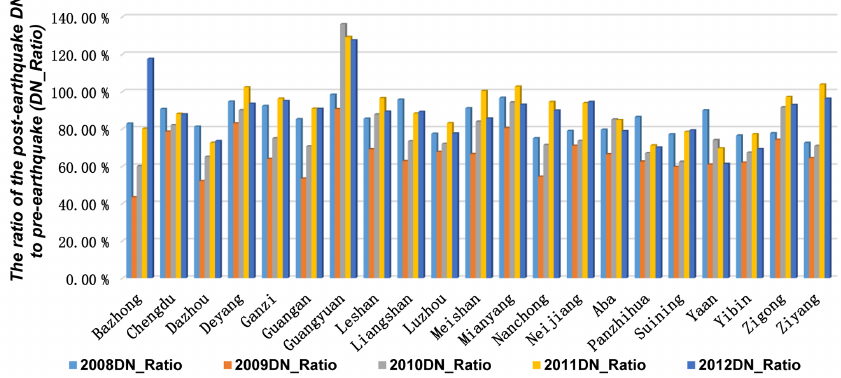
Figure 9. The ratio of the post-earthquake DN to pre-earthquake DN in Sichuan (DN_Ratio).